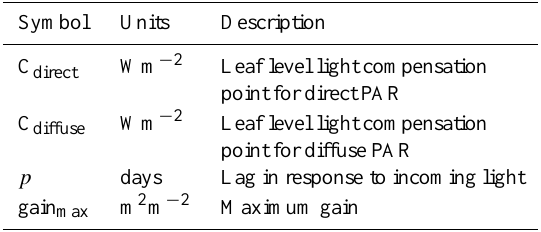
Table 2. Model parameters for leaf gain processes. Symbol Units